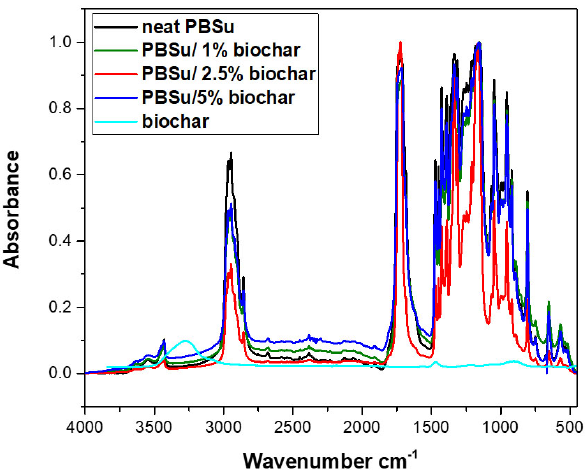
Figure 1. FT-IR spectra of neat PBSu and PBSu–biochar biocomposites.